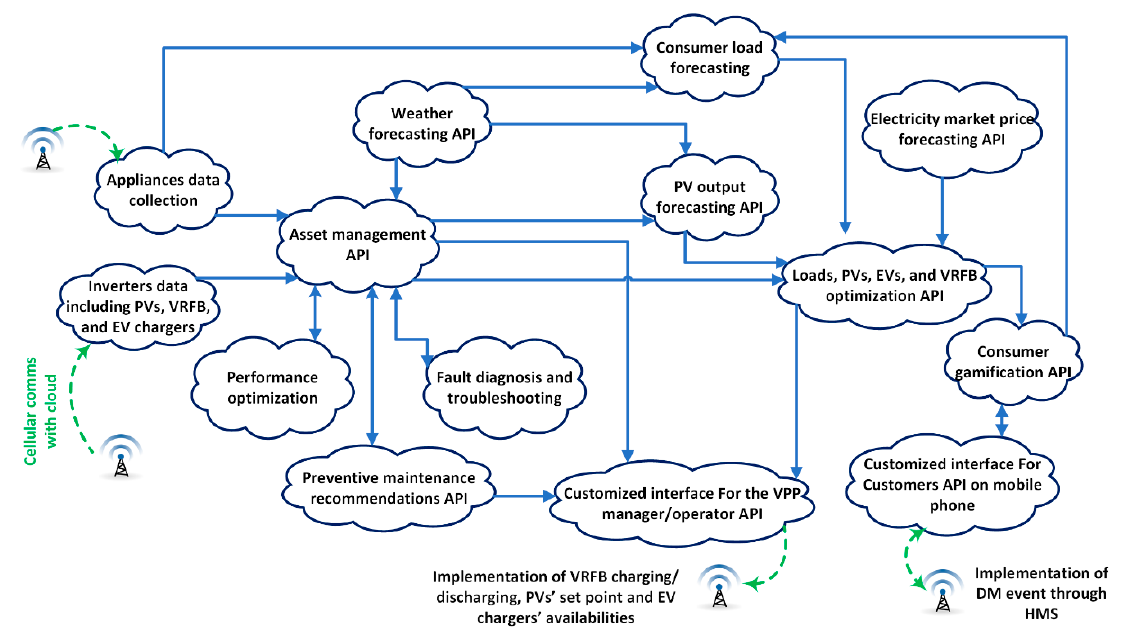
Figure 8. The proposed configuration of the cloud ‐ based monitoring and control system APIs for the VPP. EV: electric vehicle.